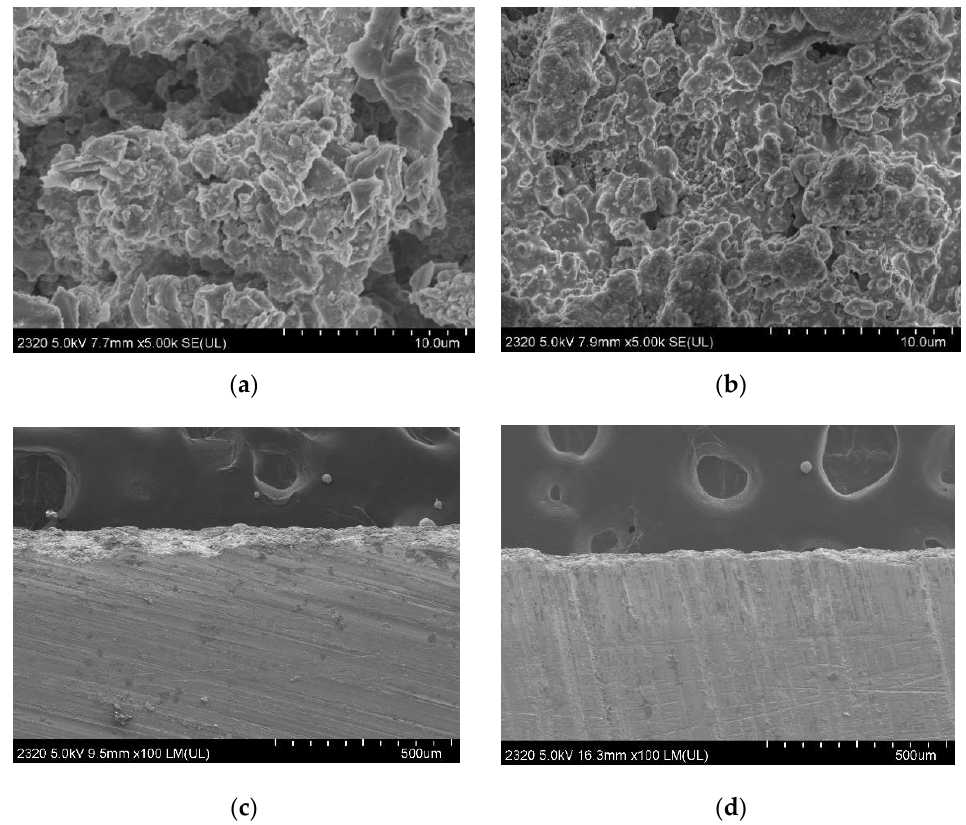
Figure 5. Surface morphology of the two coatings: high magnification of WC-10Co-4Cr coating ( a ) and WC-10Co-4Cr+CeO 2 coating ( b ); low magnification of WC-10Co-4Cr coating ( c ) and WC-10Co- 4Cr+CeO 2 coating ( d ).